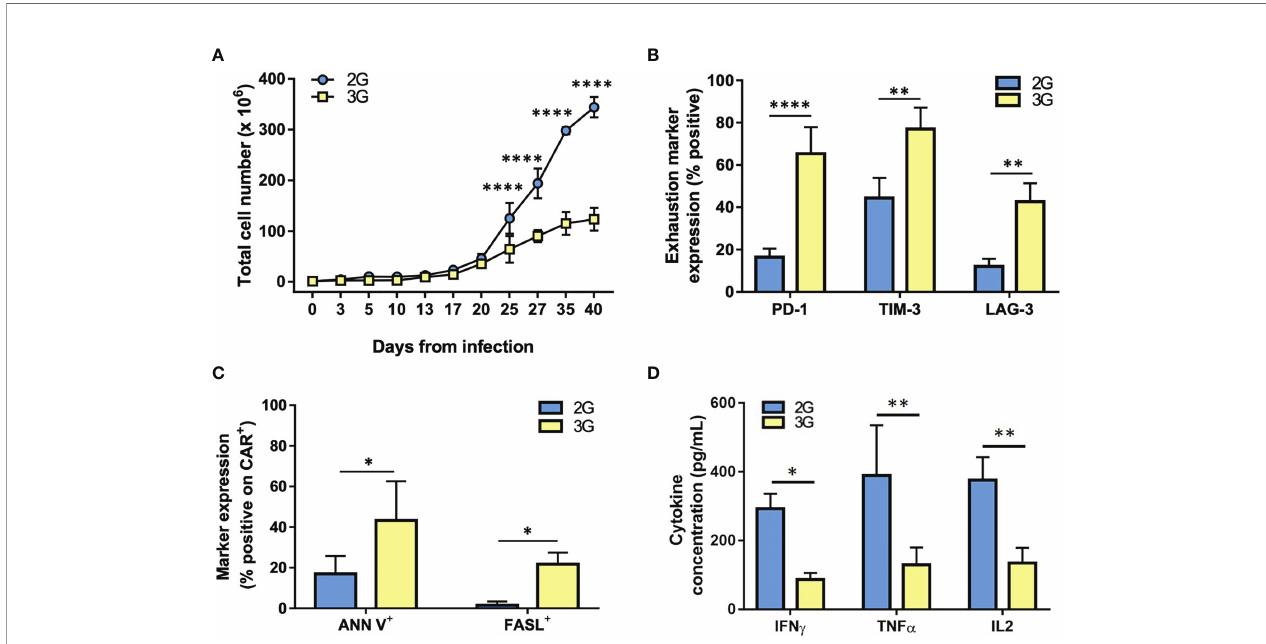
FIGURE 4 | 3G CAR T cells undergo exhaustion during in vitro expansion. (A) Cell expansion of the 2G (light blue) and 3G (yellow) CAR-expressing populations upon weekly antigen stimulation. (B) Quanti fi cation of exhaustion marker expression at 25-35 days from transduction. (C) Quanti fi cation of ANN V + and FASL + in 2G and 3G CAR populations at 25-35 days from transduction. (D) Cytokines production upon stimulation with PC3-PSMA target cells at 25-35 days from transduction. Figures show the mean +/- SD of 3 independent experiments. *p < 0.05, **p < 0.01, ***p < 0.001****p < 0.0001 by two-way